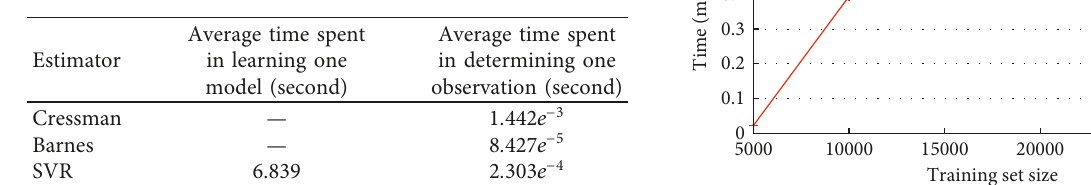
Table 11: Execution time for spatial quality control based on estimation model.